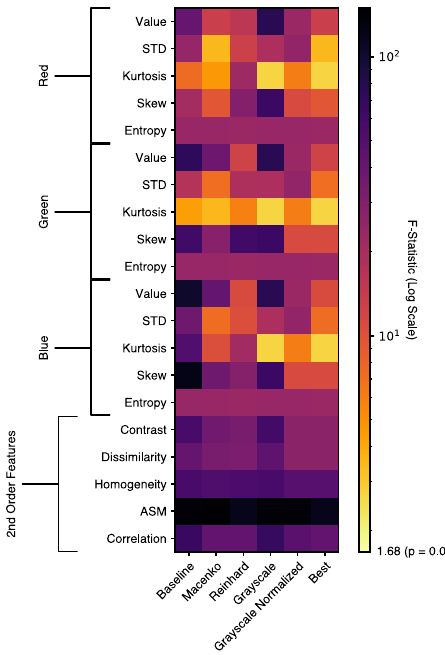
Fig. 4 ANOVA F-statistic for fi rst- and second-order image characteristics for breast cancer histology in TCGA. Variance in fi rst- and second-order image characteristics between tissue submitting sites in the breast cancer TCGA dataset ( n = 888 slides over 14 sites) is assessed with ANOVA. The ANOVA F-statistic is listed for multiple methods of stain normalization, with the lowest F-statistic (least variability) with any method of normalization indicated in the rightmost column. Stain normalization does not completely resolve fi rst-order stain variability (by F-statistic), and minimal impact is seen on second-order Haralick features. STD standard deviation, ASM angular second